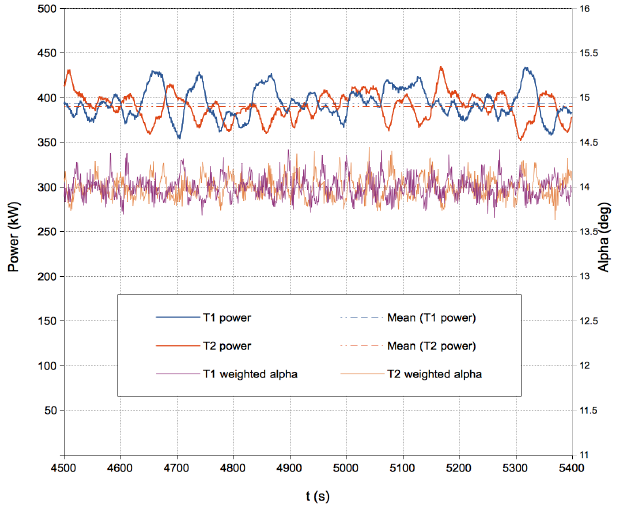
Figure 17. Diagnostic output from both rotors, T1 and T2, showing power, and α , the weighted mean angle of attack (see Creech et al. [4] for details) for each. The dashed lines indicate mean power